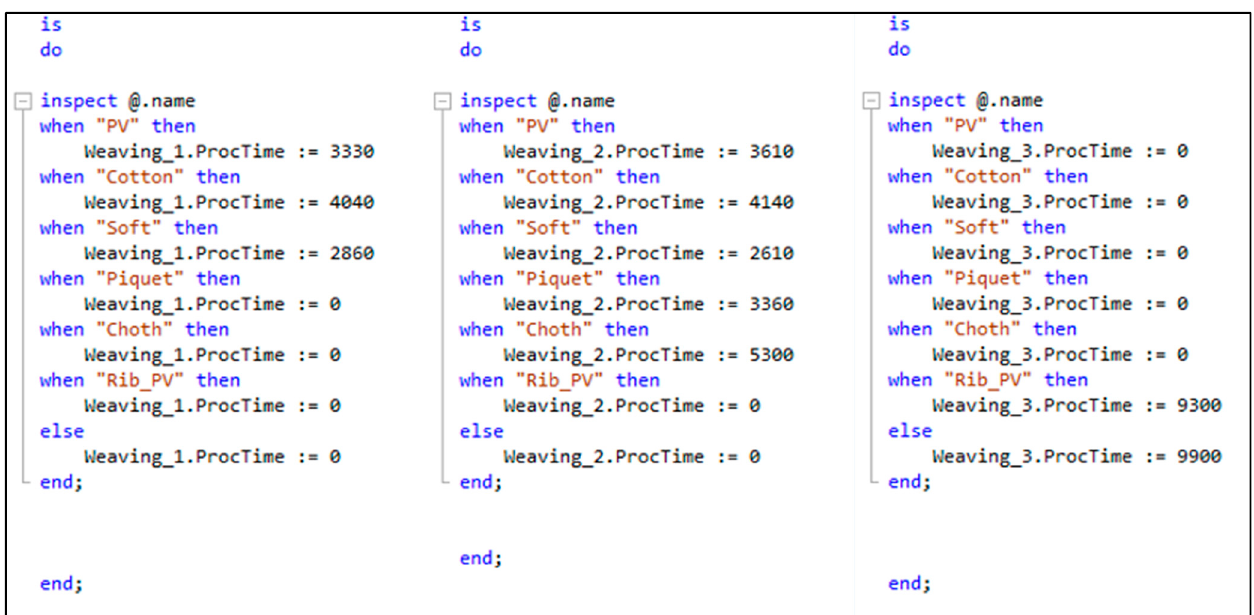
Figure 4. Programming code for processing time control of weavings.